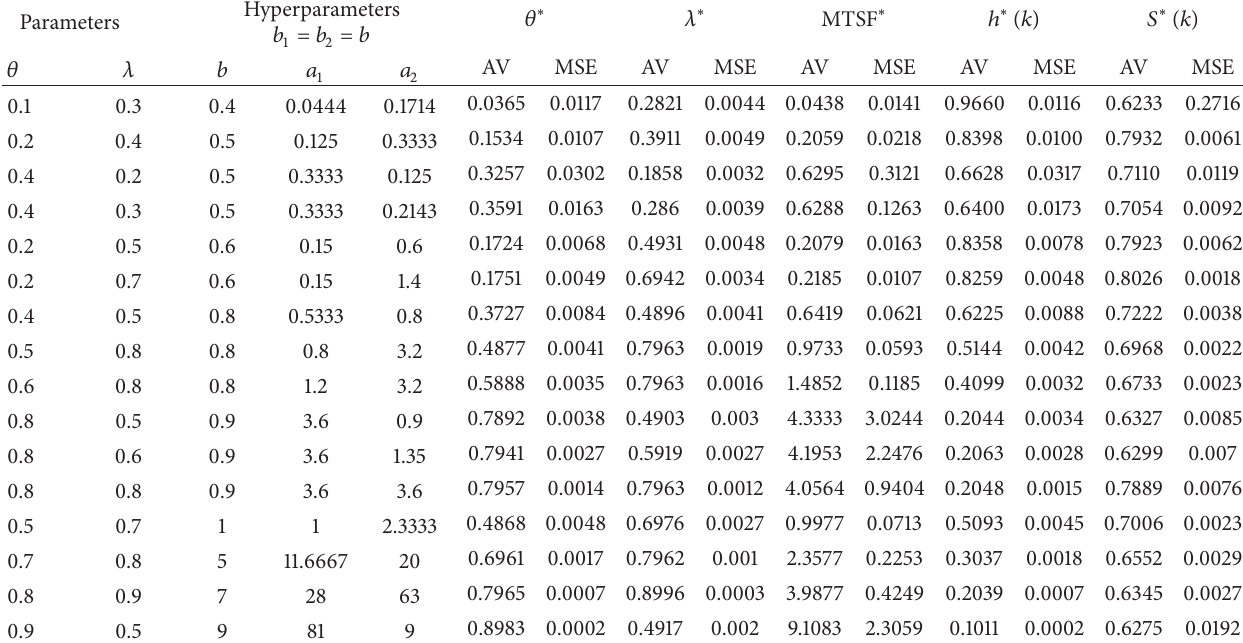
Table 6: Bayes estimates under ELF.